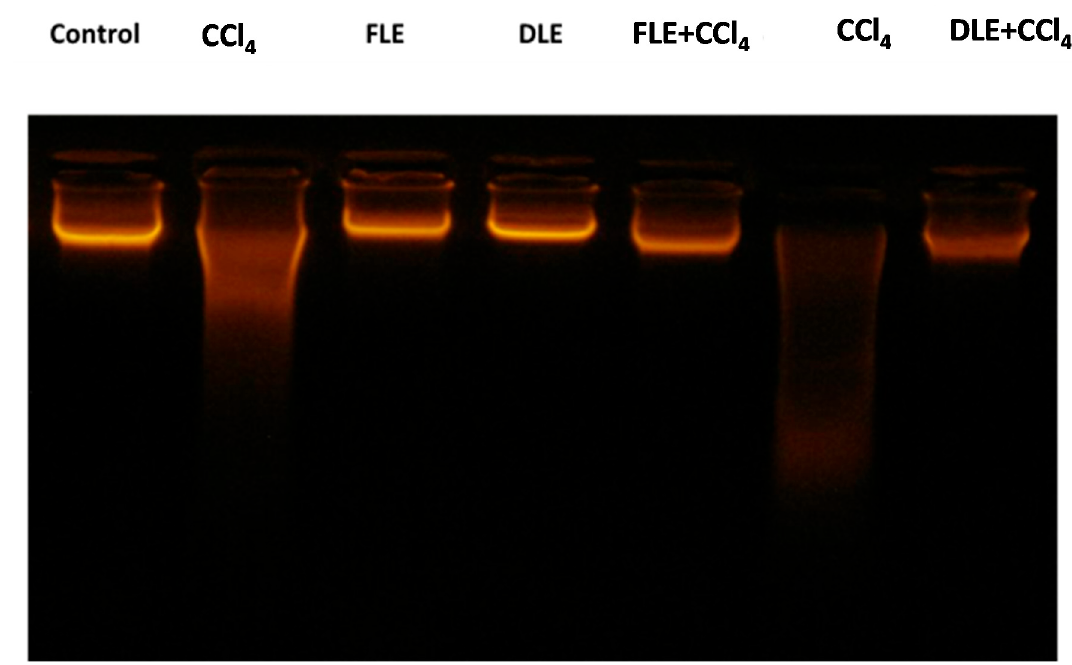
Figure 4. Agarose gel electrophoresis of DNA fragmentation. Lane 1: control hepatic tissue DNA; lane 2 and lane 6: CCl 4 intoxicated liver DNA, lane 3 and lane 4: FLE- or DLE-treated liver DNA; lane 5 and lane 7: FLE + CCl 4 - or DLE + CCl 4 - treated liver DNA.